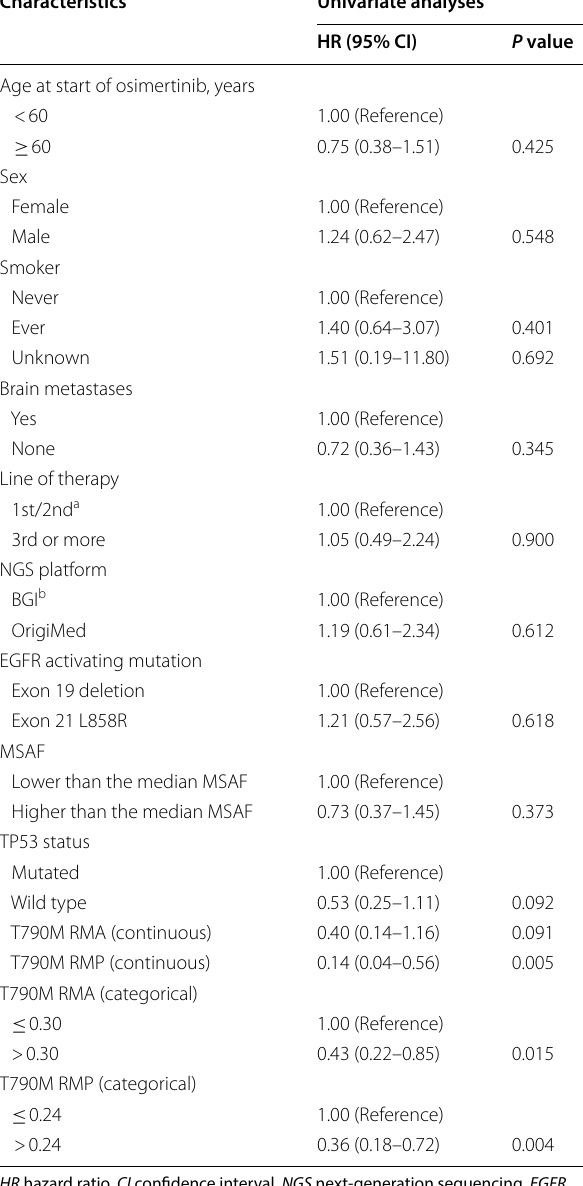
Table 2 Univariate analysis for progression free survival in our cohort